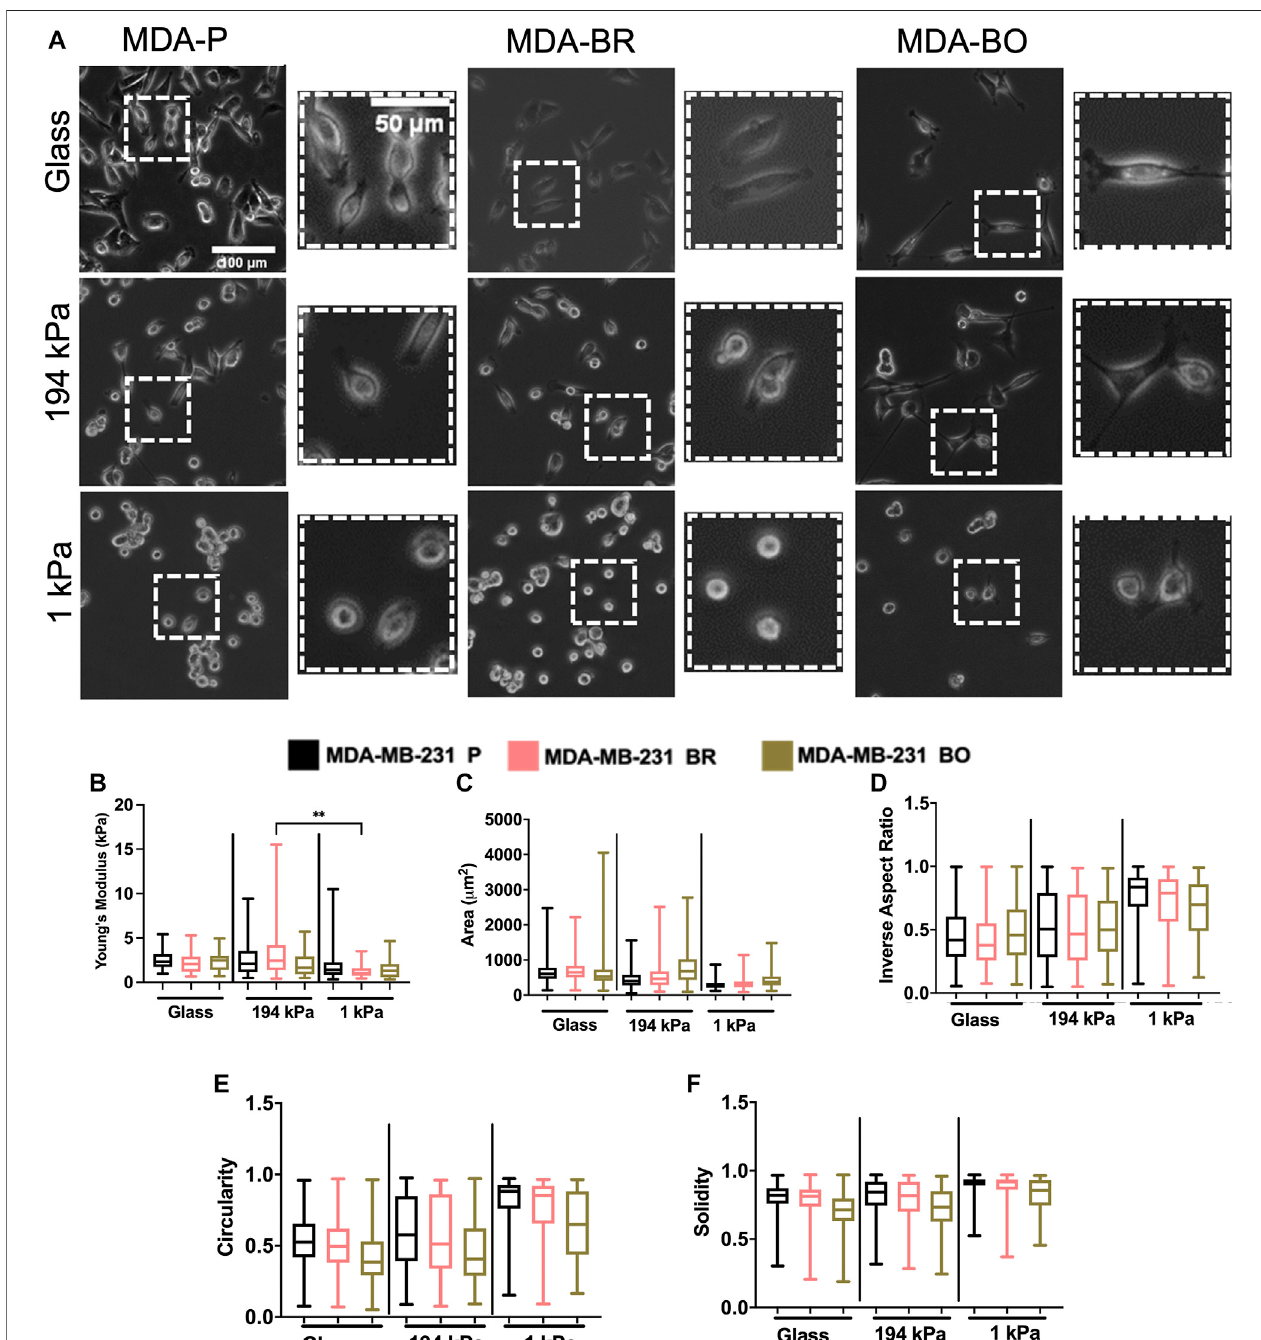
FIGURE5| MechanobiologicalcharacteristicsofMDA-P,MDA-BR,andMDA-BOcellsonstiffandsoftsubstrates (A) PhasecontrastimagesofMDA-P,MDA-BR, and MDA-BO cells on glass, 194 kPa, and 1 kPa. Scale bars represent 100 μ m (in zoomed out images) or 50 μ m (in zoomed insets). (B) Young ’ s modulus from atomic forcemicroscopy of each cell type on glass, 194 kPa, and 1 kPa. Also shown are cell (C) area, (D) inverse aspect ratio, (E) circularity, and (F) solidity on each substrate. Boxandwhiskerplotsrepresenttheminimumandmaximumdatapoints,themedian,andtheinterquartilerange.**indicates p < 0.01.Eachcolumnofdataisfrom N > 28 cells pooled from at least 3 independent experiments. See additional statistics in Supplementary Table S1 . The data were tested for normality using the D ’ Agostino and Pearson test. Data for Young ’ s modulus followed a normal distribution for some groups, and hence a two-way ANOVA and multiple comparison test were performed to determine signi fi cance for those data. Data for morphology did not follow a normal distribution, and hence a Kruskal Wallis test and Dunn ’ s multiple comparison test was performed to determine signi fi cance for those data sets.